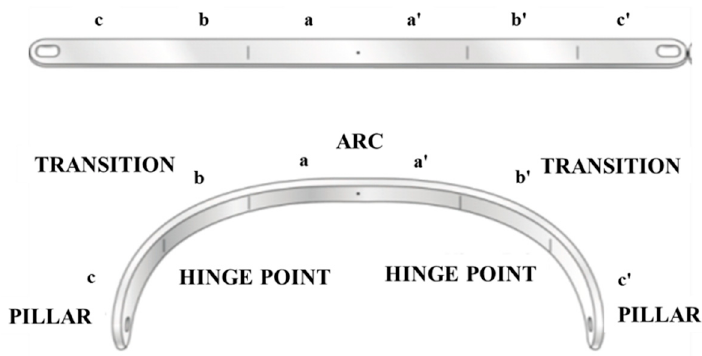
Figure 13. Three components of the Nuss bar. Arc and transition were used to draw the test sample for the bending test.